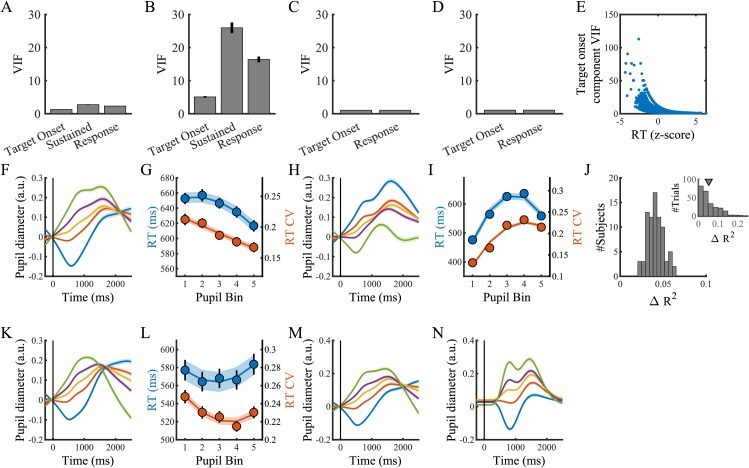
Application of the linear up-ramp model on a single-trial basis. (A–D) Variance inflation factor (VIF) values for each of the temporal components of the (A) linear up-ramp model applied across trials, (B) linear up-ramp model applied to individual trials, (C) target and response onset model applied across trials, and (D) target and response onset model applied to individual trials. (E) Single-trial VIF values for the target onset component of the linear up-ramp model, plotted against RT. (F) The pupil time course and (G) the relationship between the size of the pupil response to target onset and behavioural performance when trials with VIF values larger than five were excluded. (H–I) Same conventions as F-G, but binned by the estimated amplitude of the sustained component of the linear up-ramp model. (J) Average difference in R2 between a single trial linear up-ramp model and the target-response onset model per subject, inset displays this same difference value for one example subject across trials. (K–L) Same conventions as F-G, but sorted by the estimated amplitude of the target onset component in the target-response onset model. (M) Pupil time course and (N) fitted pupil diameter time course binned by the estimated amplitude of the target onset component in the linear up-ramp model. Error bars and shaded regions denote ±1 standard error of the mean (SEM). Stats, linear mixed effects model analyses (Statistical analyses).